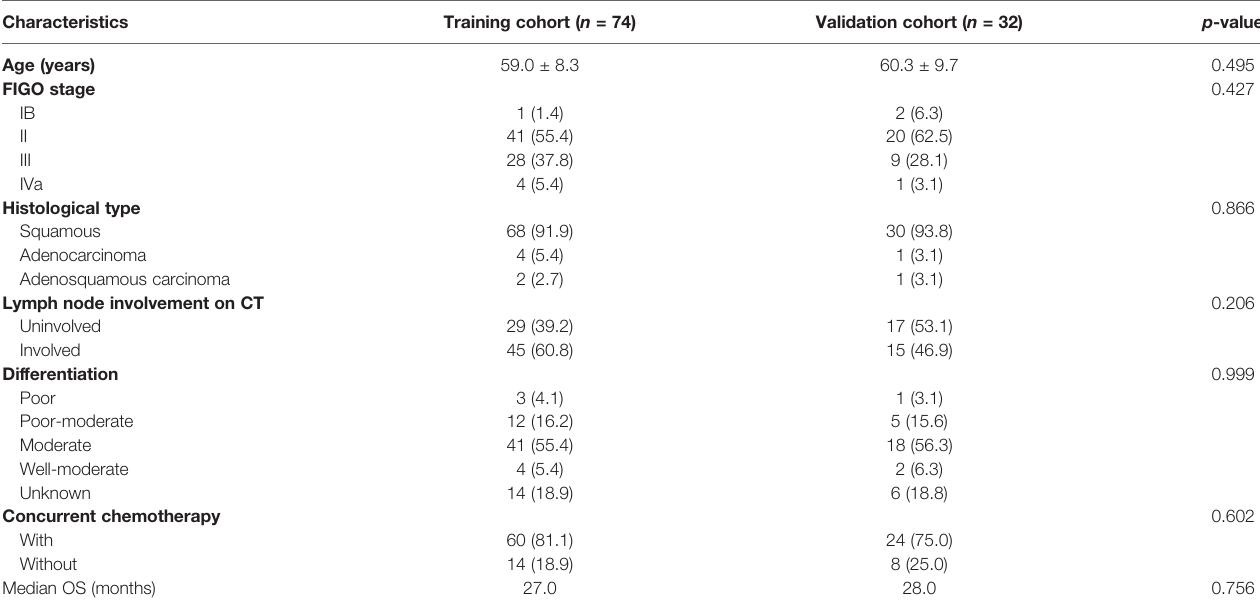
TABLE 1 | Patients ’ characteristics.